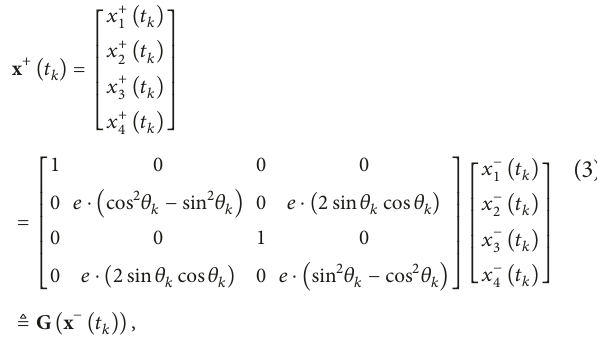
the 𝑦 -axis is on the orbital plane and perpendicular to the 𝑥 -